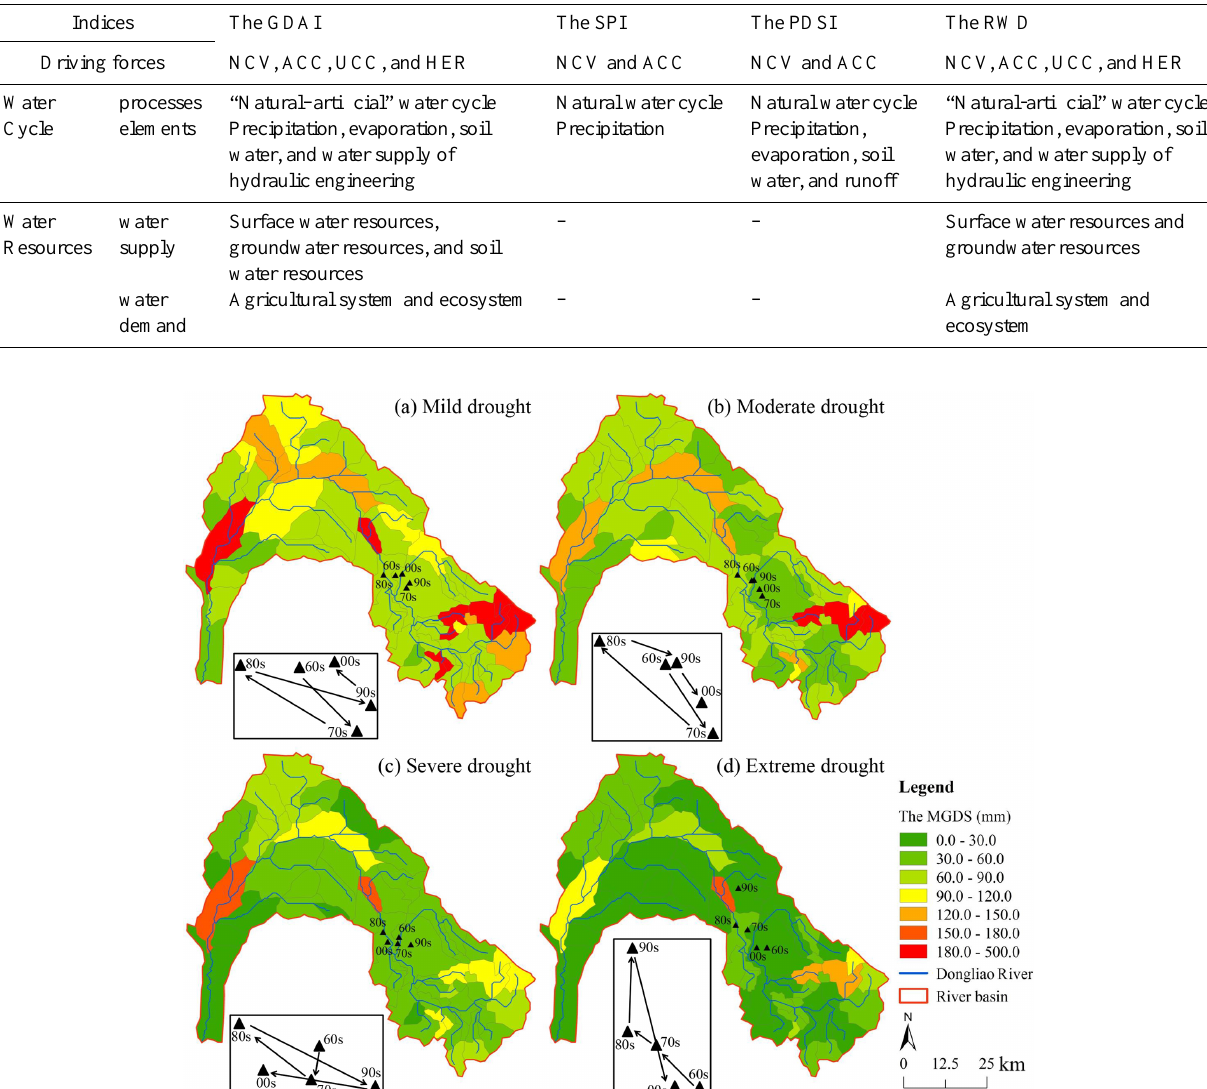
Table 7. Comparing the GDAI with the SPI, the PDSI, and the RWD.